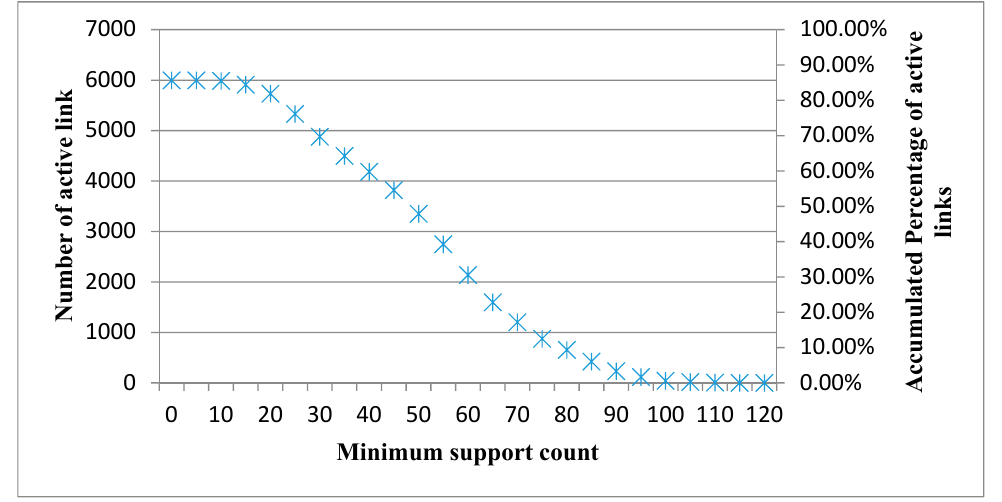
Figure 7. Number of active links in transaction-based networks (TBN).